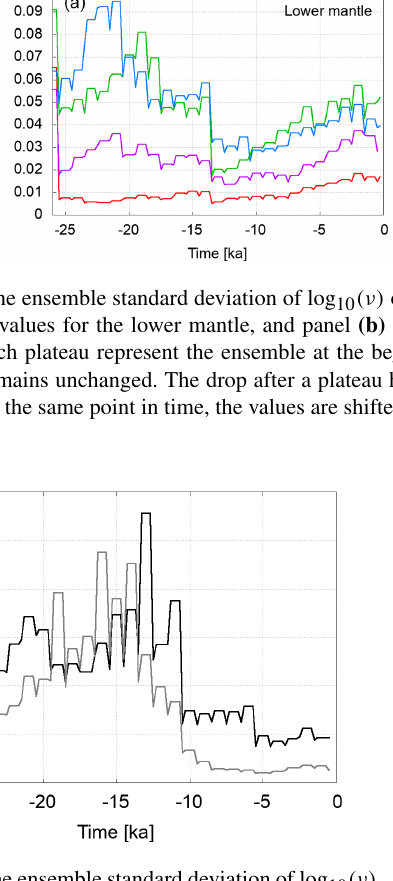
Figure 12. Variation in the ensemble standard deviation of log 10 (ν) over time for Case E. The black curve shows the values for the lower mantle and grey curve for the upper mantle, respectively. Due to the observation uncertainties being higher than in Cases A–D the uncertainty of the viscosity estimate is also